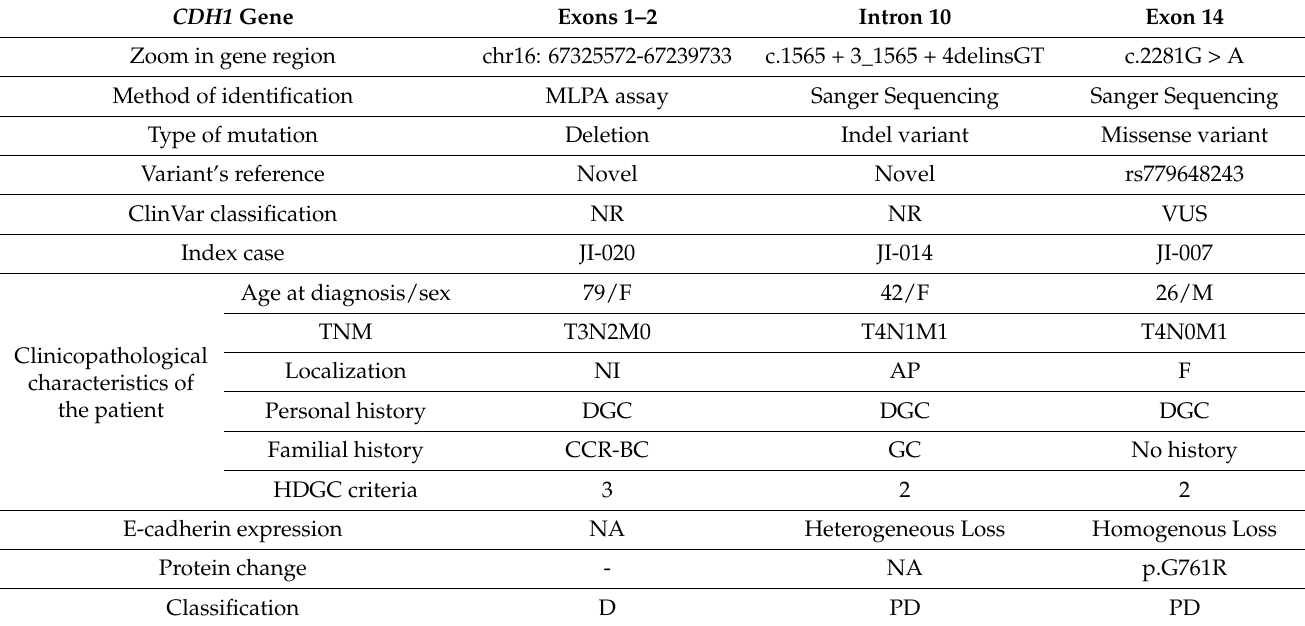
Table 2. Characteristics of the predicted pathogenic and probably pathogenic